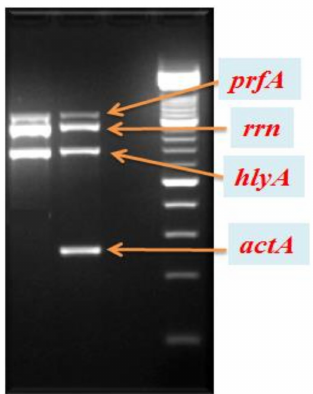
Figure 1. Polymerase chain reaction (PCR)-based virulence genes of L. monocytogenes strains isolated from food, environmental surfaces, and biological